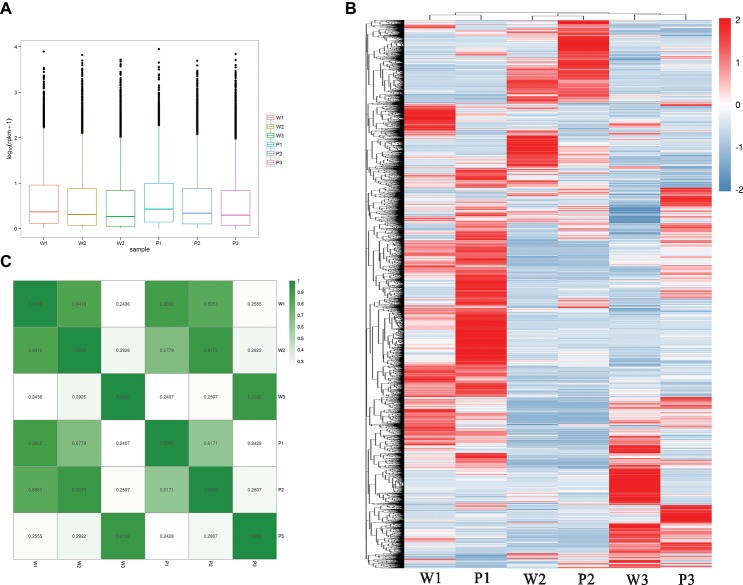
Transcriptome dynamics during the various stages of flower development. (A) Distributions of the expression levels of all unigenes. (B) Heatmap comparing scaled expression values for M. malabathricum purple and white varieties across developmental stages. The blue bands indicate low gene expression levels; the red bands indicate high gene expression levels. (C) Pairwise correlations of gene expression between any stages of flower development in two M. malabathricum varieties are shown. The differentially expressed genes were identified by comparing the RPKM with |log2 fold change| > 2.0 and FDR-adjusted p ≤ 0.01.